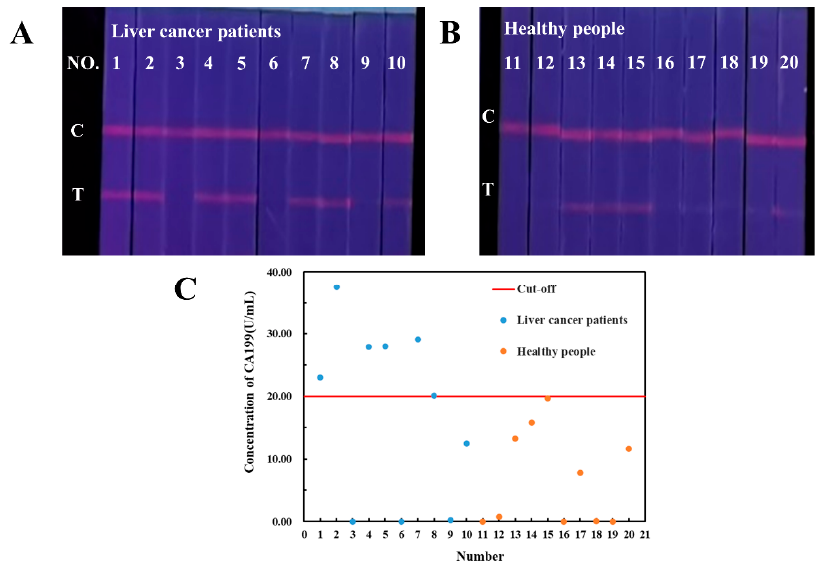
Figure 4. Qualitative results of CA199 in liver cancer patients ( A ) and healthy people ( B ), CA199 levels quantitatively detected by TRFM-based LFIA ( C ).